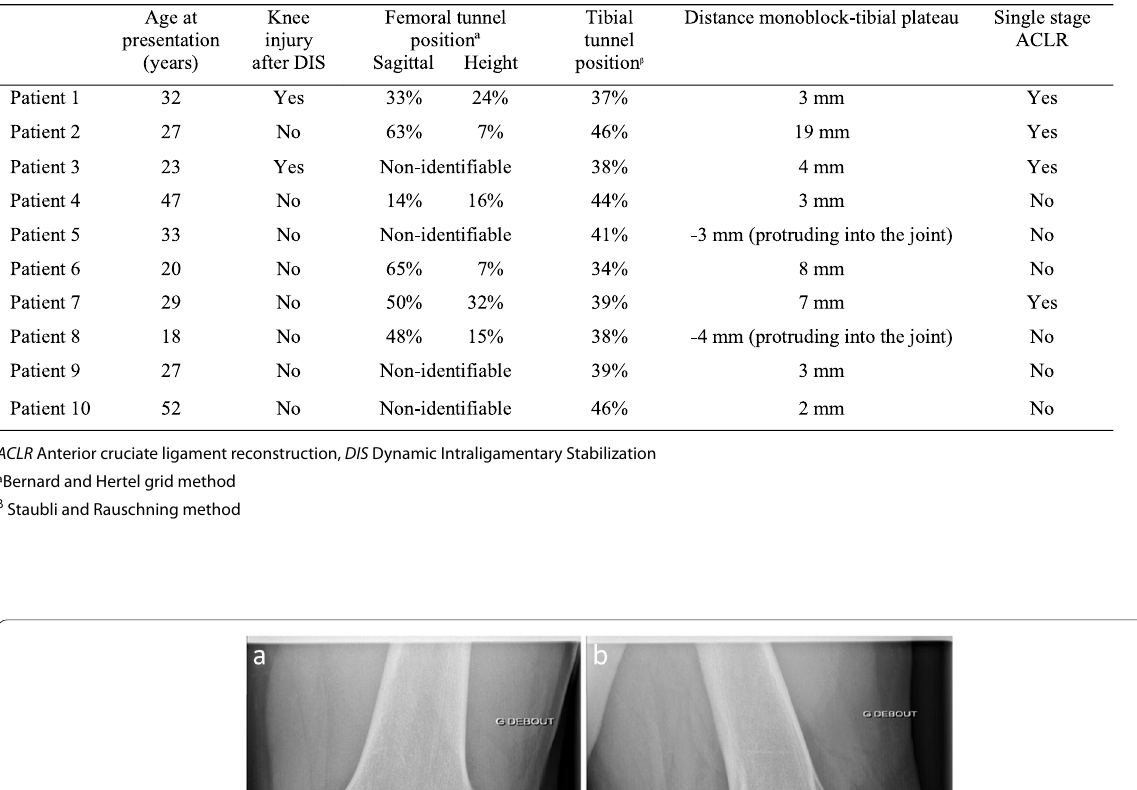
Table 1 Patient characteristics and preoperative radiographic